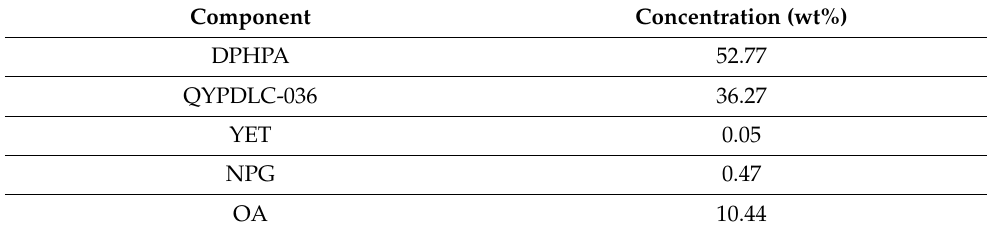
Table 4. Composition of the HPDLC.